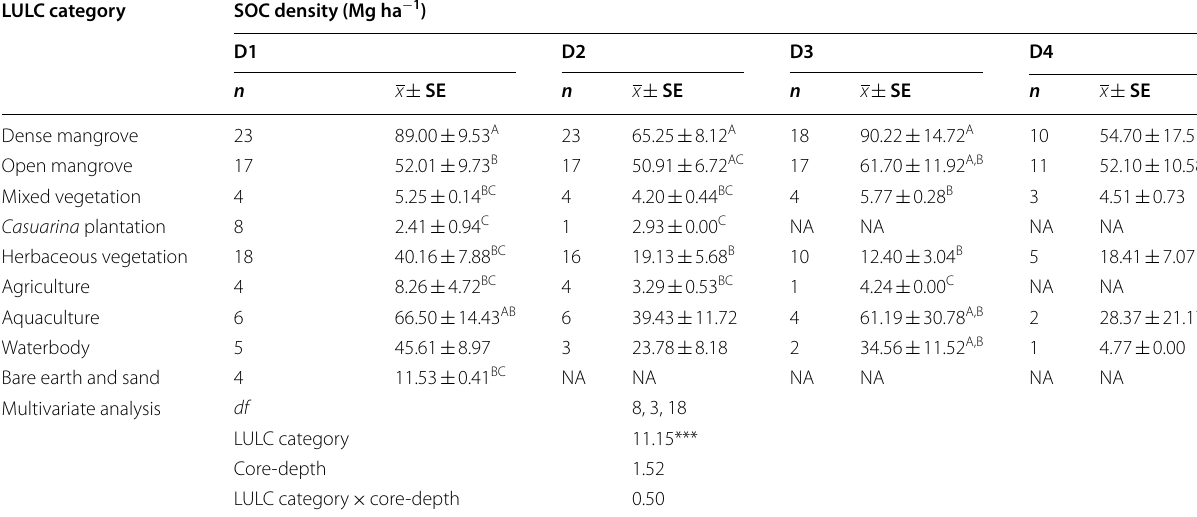
SE) values across different LULC categories and soil core-depths ±